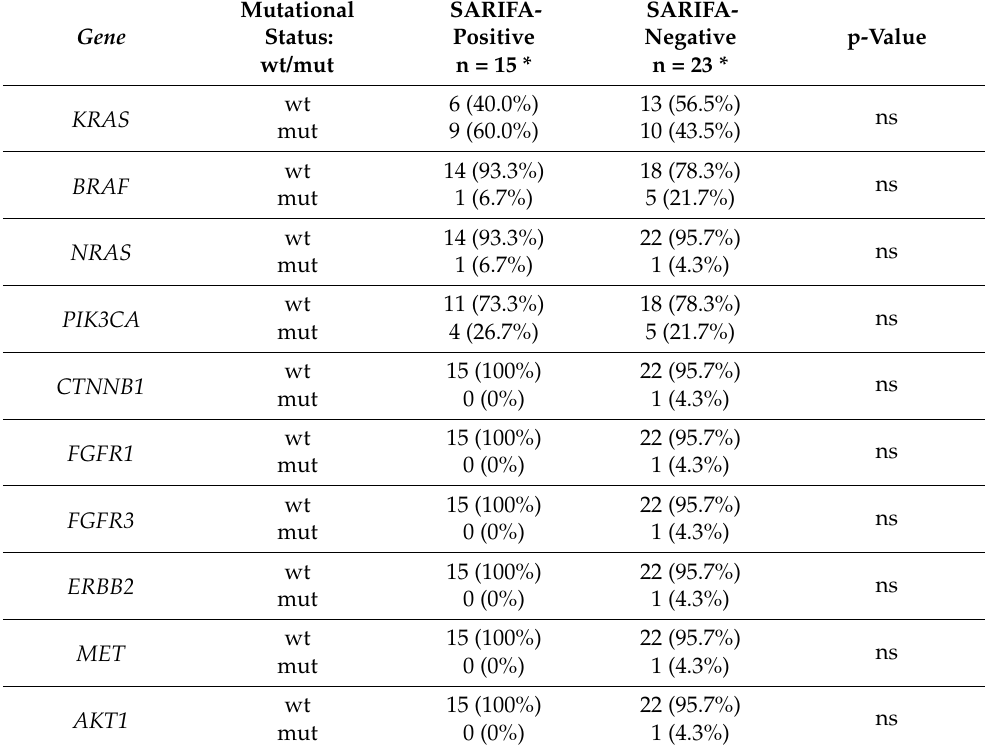
Table 2. NGS-based molecular characterization of SARIFA-positive/negative